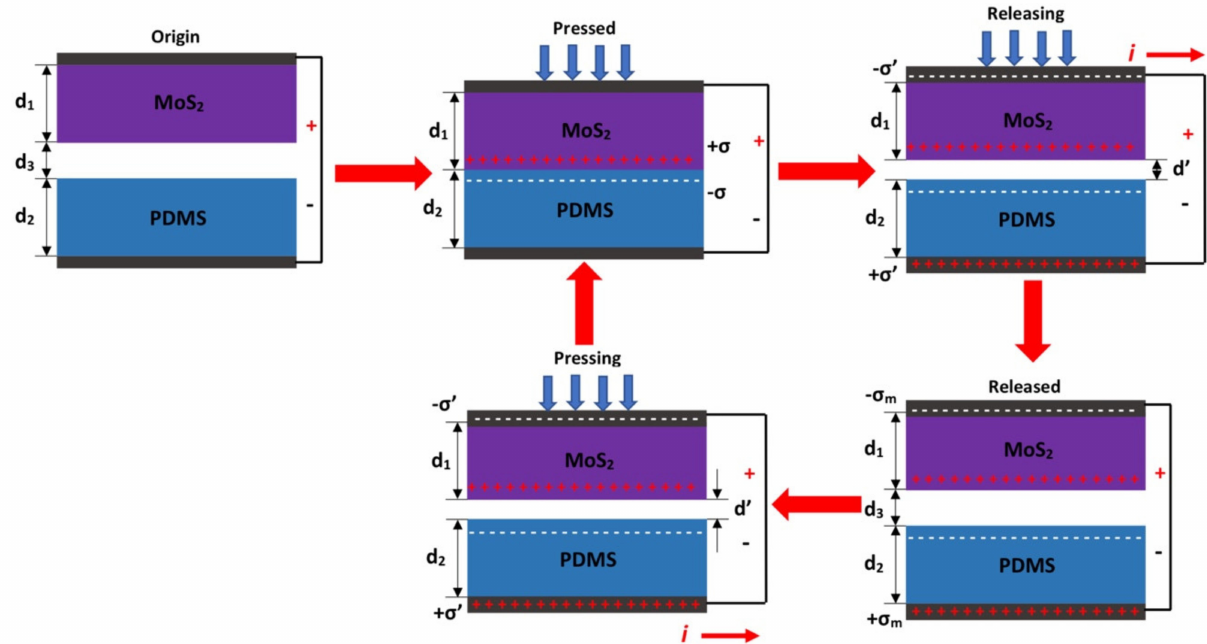
Figure 1. Schematic view of the fundamental operation in short-circuit condition of the TEH based on stainless steel/MoS 2 and